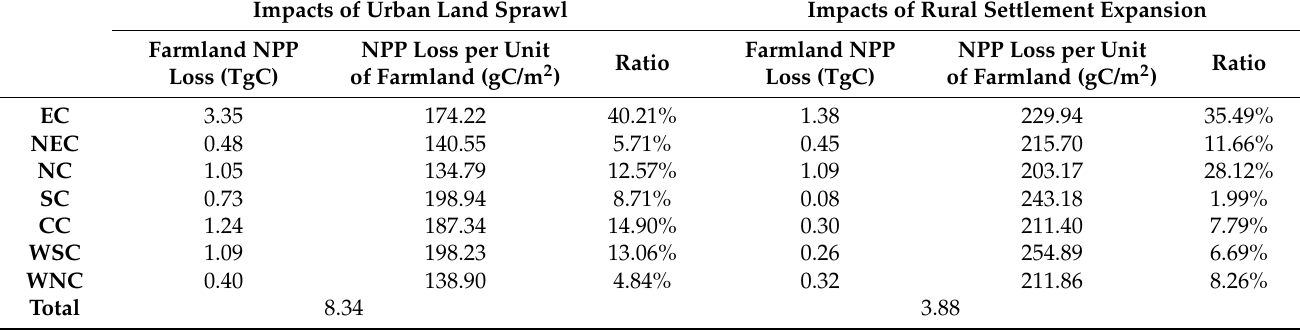
Table 2. Farmland NPP loss due to urban sprawl and rural settlement expansion between 2000 and